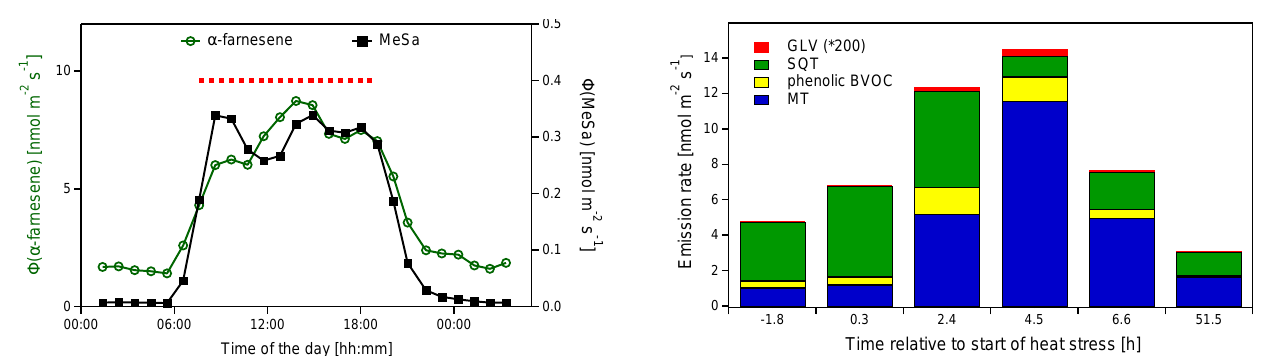
Fig. 5. Diurnal variation of the emission rates of α -farnesene (open circles, left-hand scale) and MeSa (closed squares, right- hand scale) measured at a chamber temperature of 20 ◦ C during darkness (00:00 to 05:00 and 19:00 to 00:00LT) and at 24 ◦ C dur- ing illumination, respectively. The time period of full illumination (PPFD=800µmolm − 2 s − 1 ) is indicated by the red dashed bar. the measurements and showed visible aphid infestation.